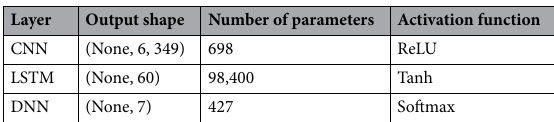
Table 2. The key features of the structure-tuned deep learning-based classifier by the GA.